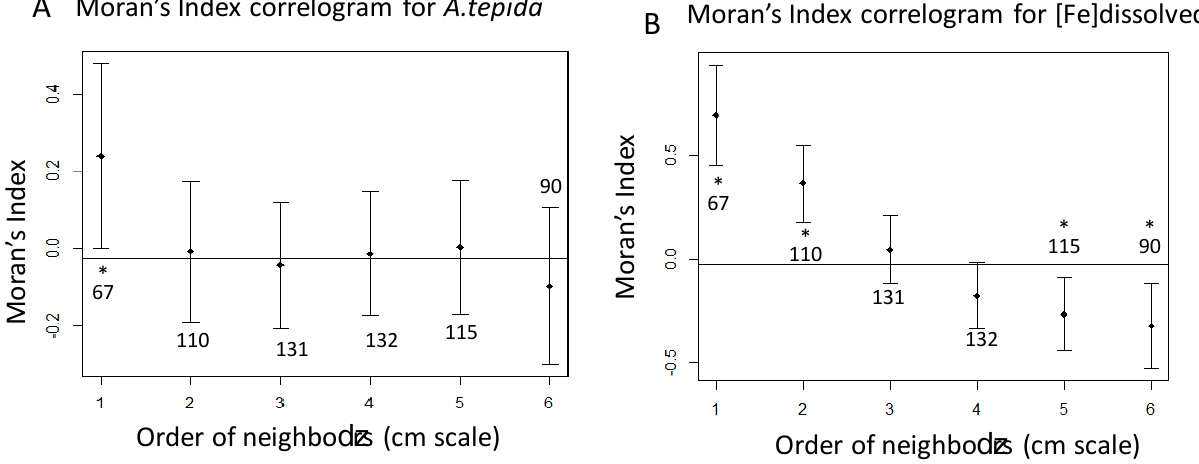
Figure 7. Moran’s index correlograms for 3 to 8cm depth. (a) Moran’s index correlogram for A. tepida with a 1cm resolution. (b) Moran’s index correlogram for [Fe]dissolved with a 1cm resolution. An asterisk indicates significant differences from zero; error bars are twice the standard deviation. The numbers are the number of pairs for each order of